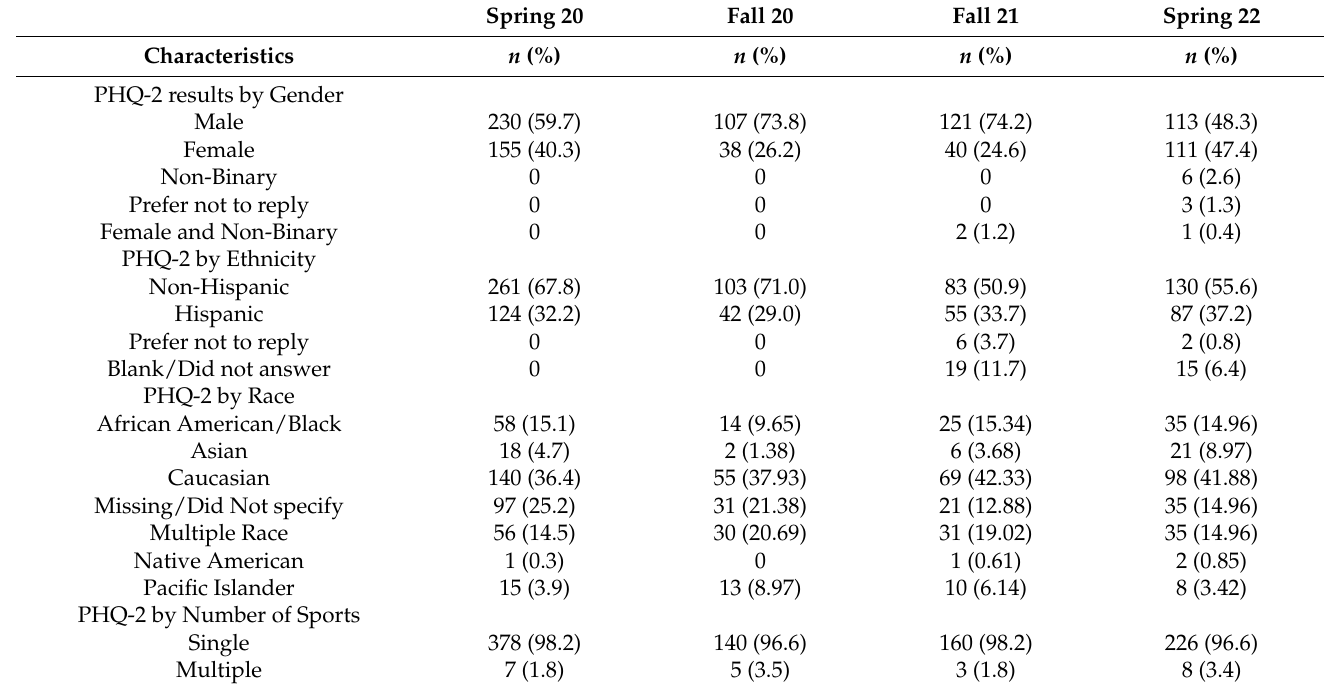
Table 1. Summary of high school athlete depression screening participant demographics. Spring 20 Fall 20 Fall 21 Spring 22